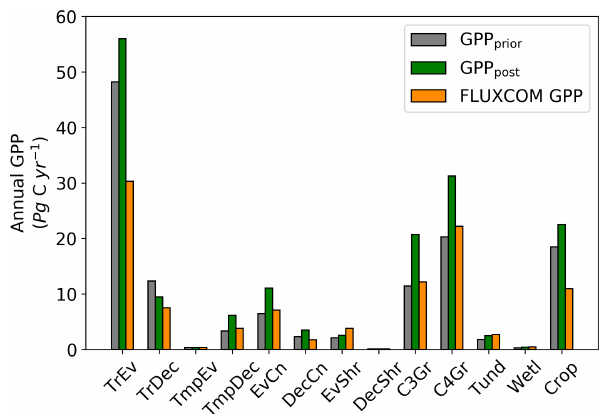
Figure 11. Northern summer (June–August) latitudinal averages of GPP prior (gray line), GPP post (green line), FLUXCOM GPP (or- ange line), TRENDY model average (light blue line) and TRENDY model spread given by the 10th and 90th percentiles (light blue